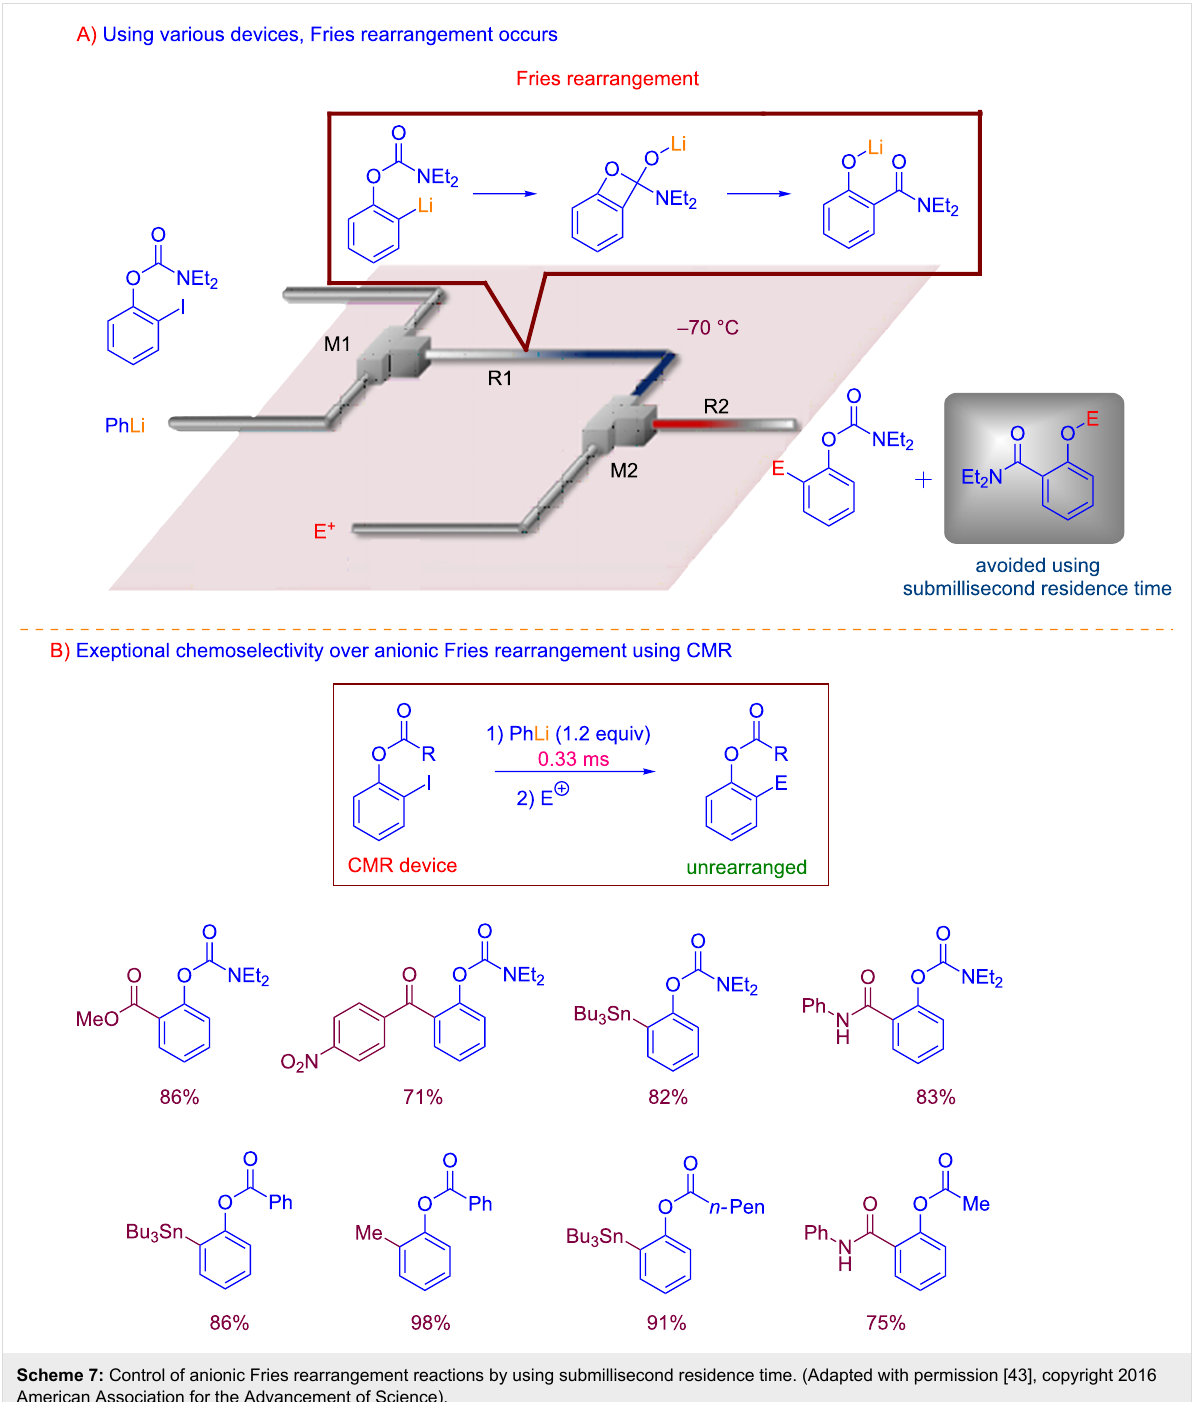
Scheme 7: Control of anionic Fries rearrangement reactions by using submillisecond residence time. (Adapted with permission [43], copyright 2016 American Association for the Advancement of Science).